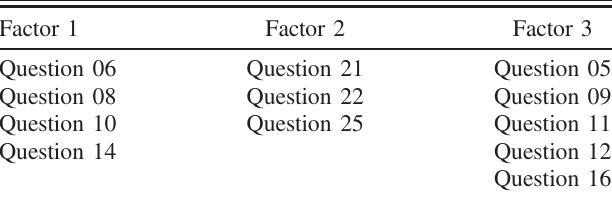
TABLE V. Theoretical three-factor model.